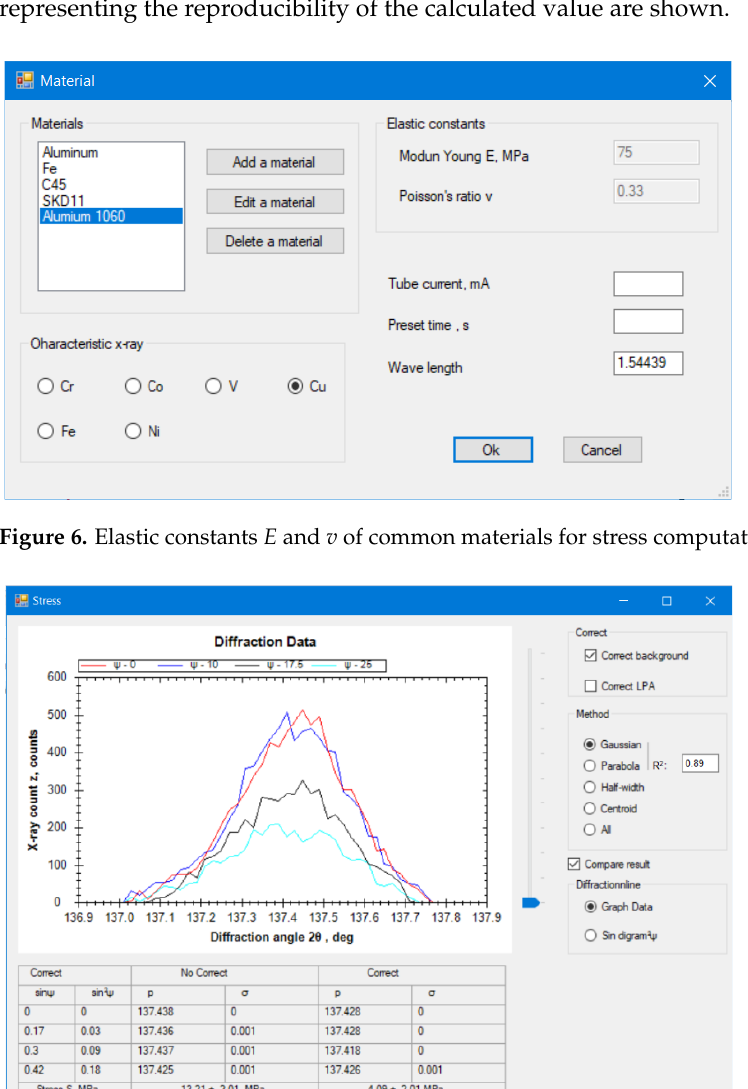
Table 1. The experimental conditions for stress measurement using XRD.